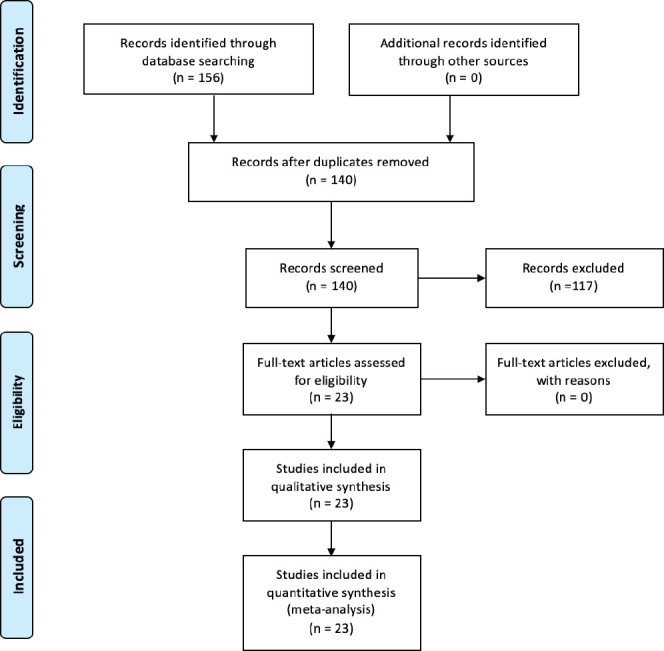
PRISMA flow diagram.